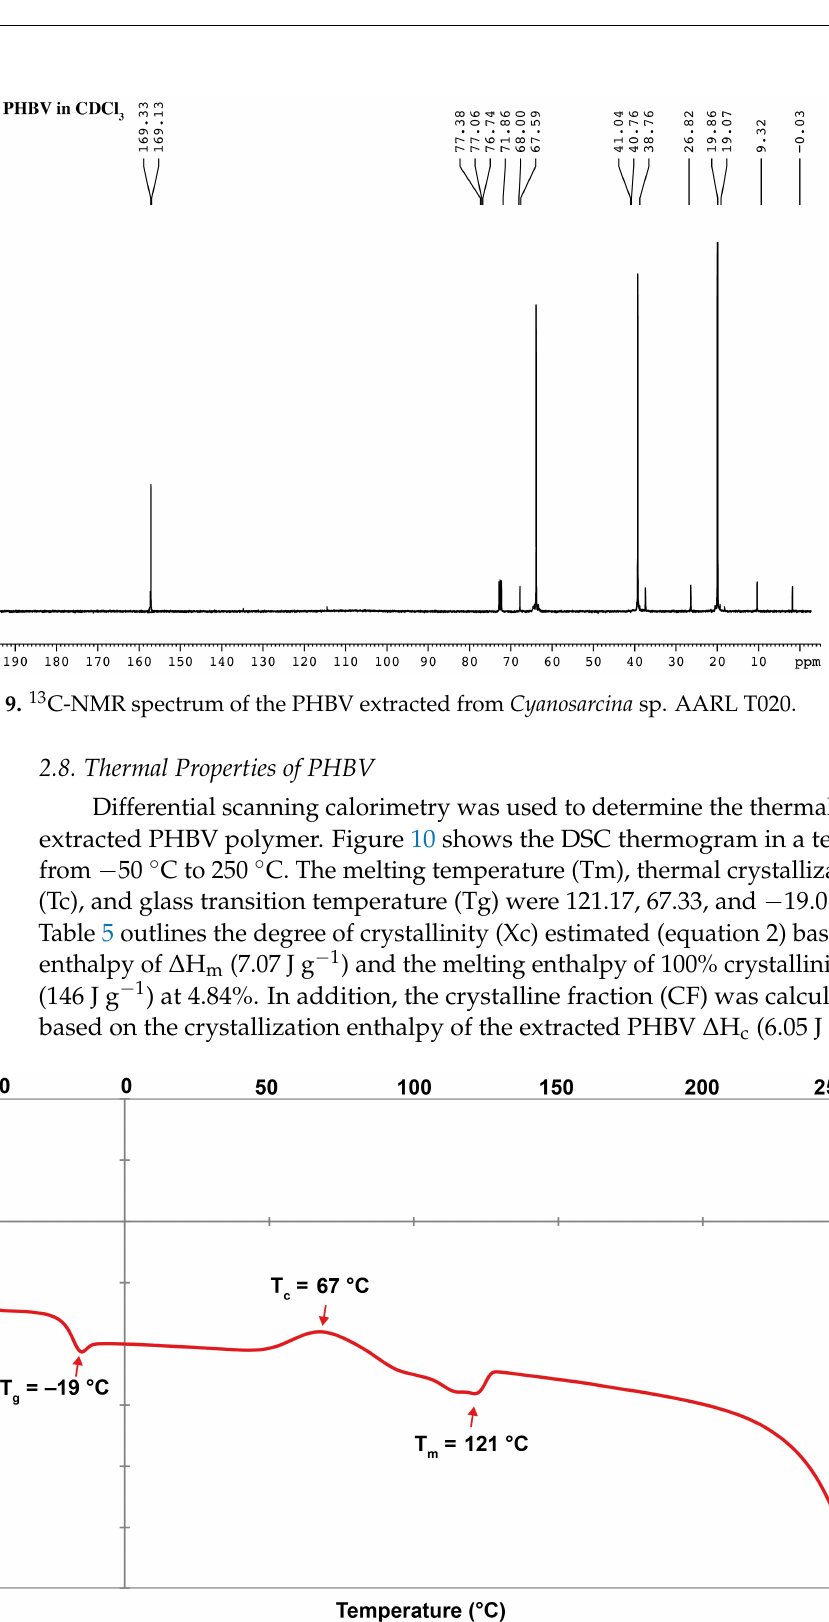
Figure 11. Thermogravimetric analysis (TGA) of PHBV from Cyanosarcina sp. AARL T020: ( a ) the weight loss curve; T d(5%) , the temperature at 5% weight loss; T max , the maximum degradation temperature; ( b ) derivatives of the weight loss curves .